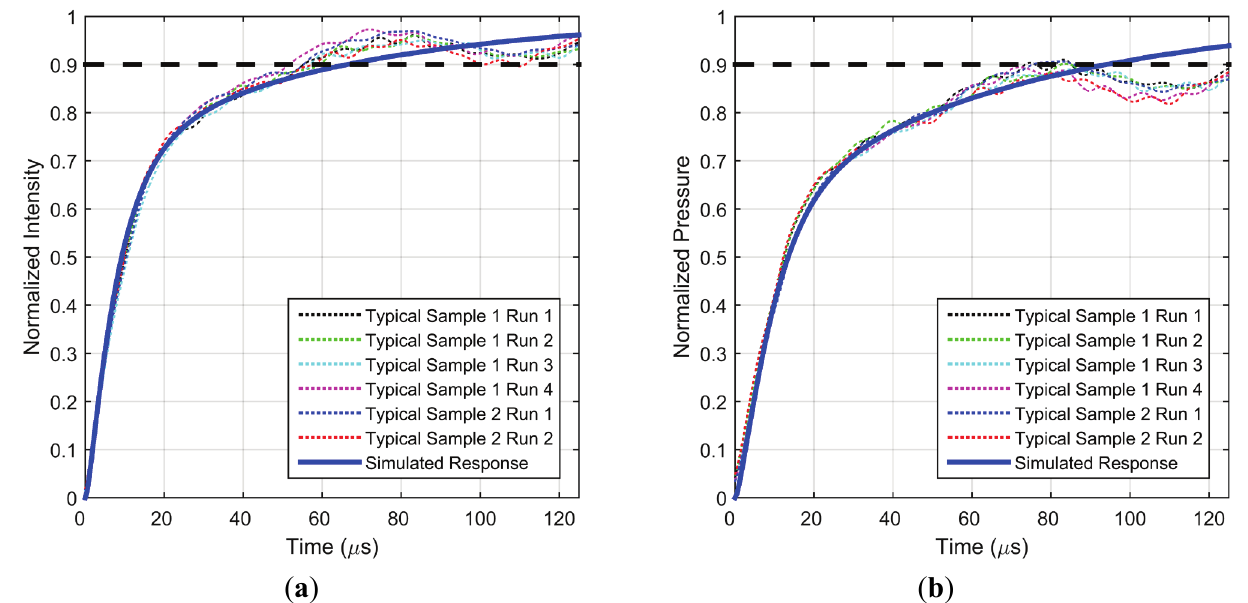
Figure 6. Measured and simulated intensity ( a ) and pressure ( b ) step response for a typical PC-PSP coating over different runs and